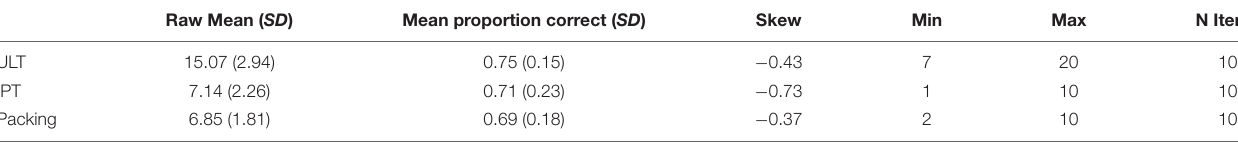
TABLE A3 | Descriptive statistics of test performance in study 2 ( N = 117) for the full test